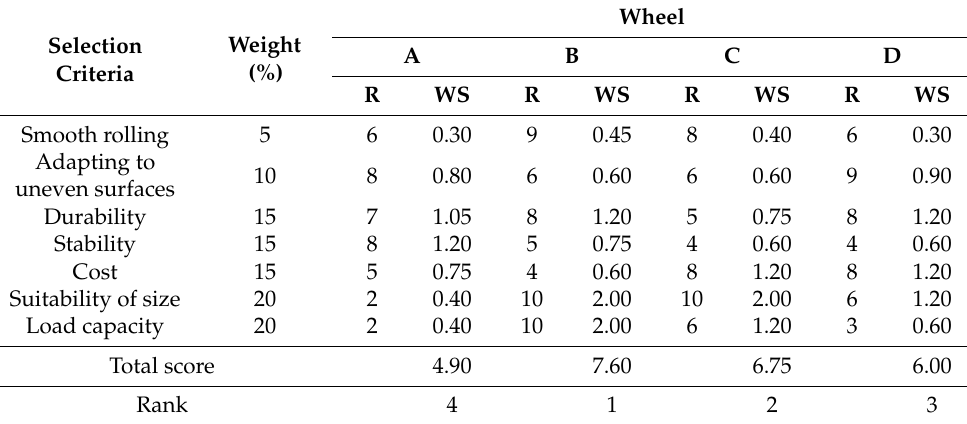
Table 3. Scoring of